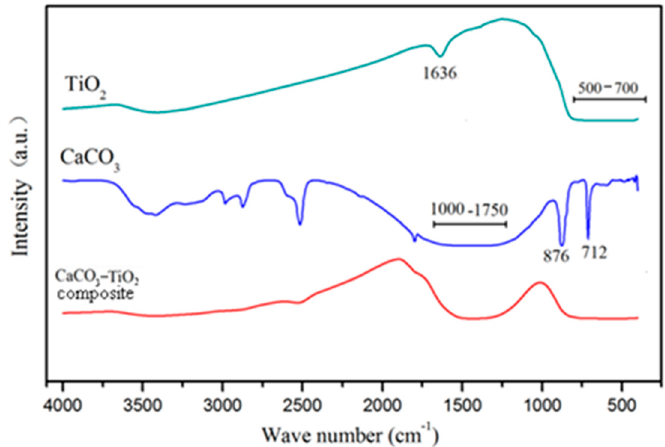
Figure 8. FT-IR spectra of CaCO 3 , TiO 2 and CaCO 3 –TiO 2 composite.